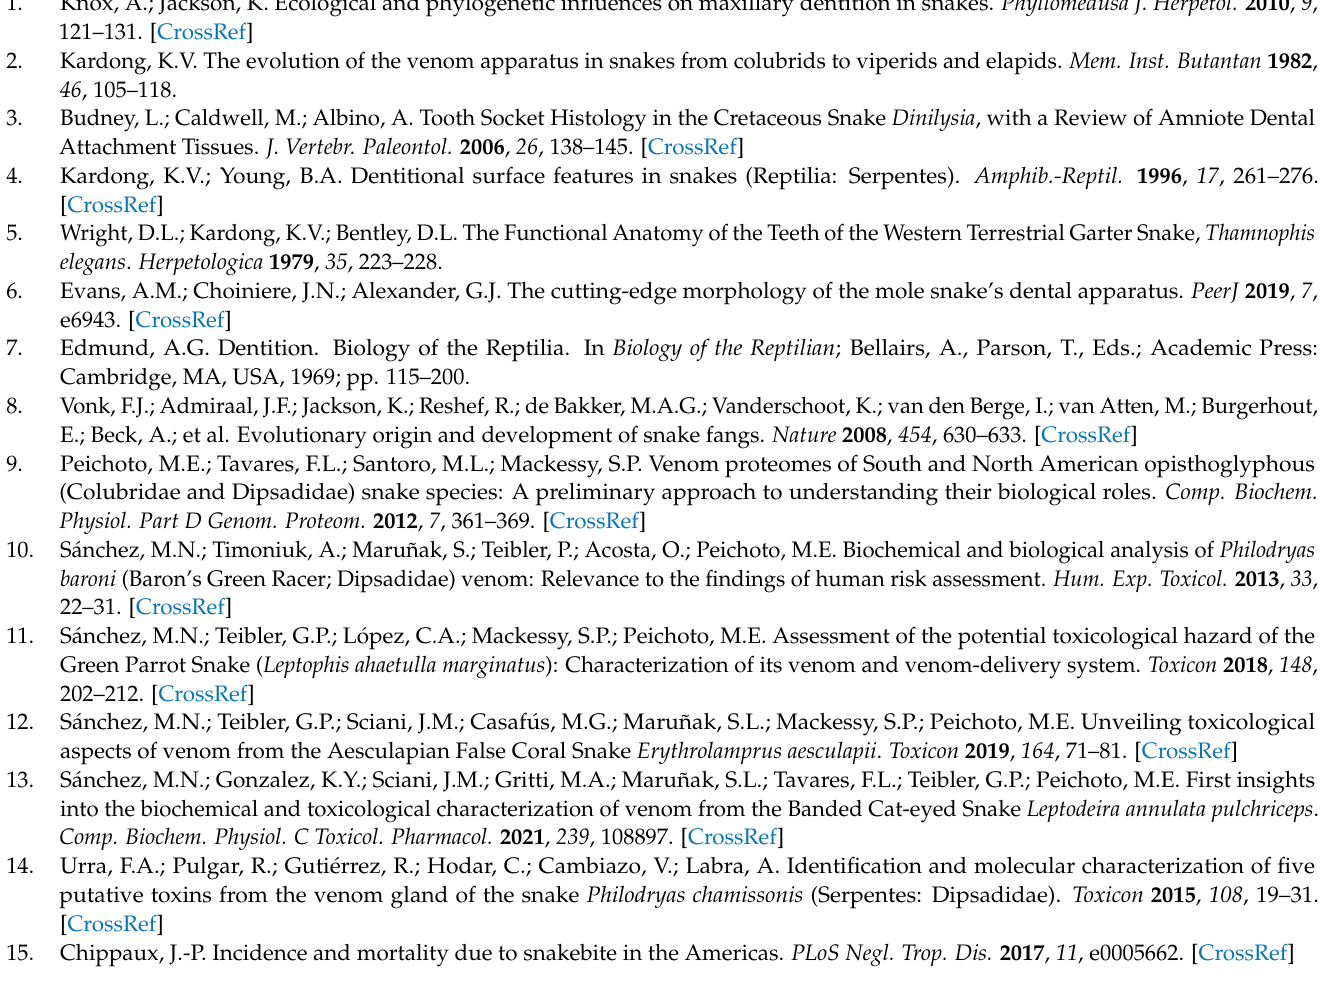
microscopy. Table S2. Specimens used in microtomography computerized. Table S3. Specimens used for